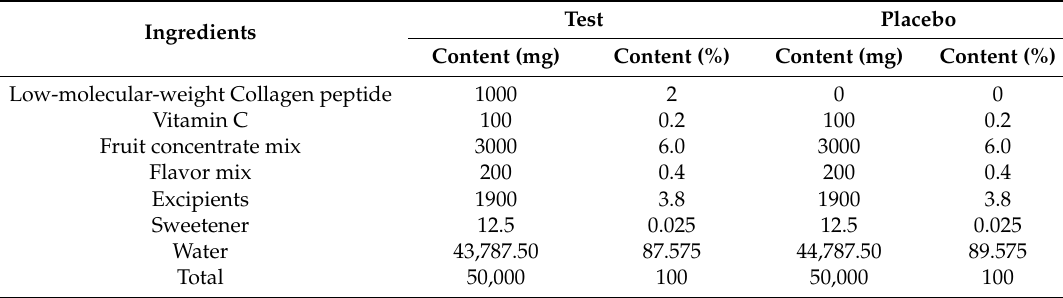
Table 1. Ingredients of test and placebo preparations.